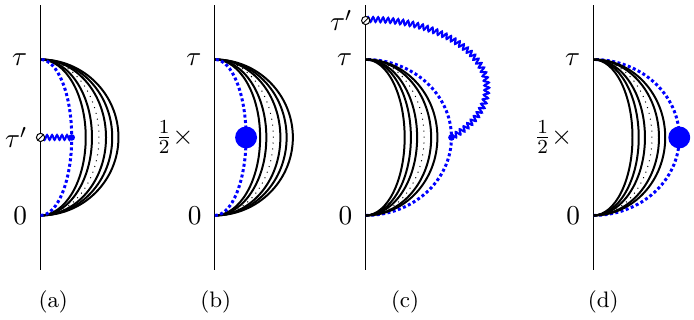
Figure 3 . Feynman diagrams contributing to H bdry . We represent fermion and gluon propagators by dotted and wiggled lines. Blue bullets represent 1-loop self-energy corrections to the propagators.